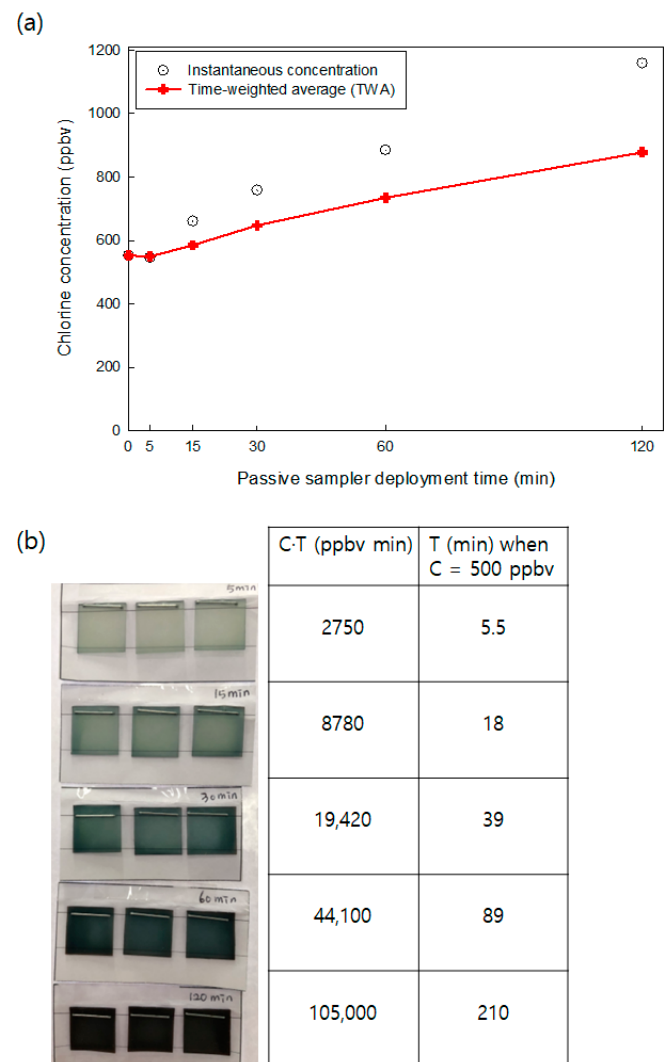
Figure 1. ( a ) Instantaneous chlorine concentration and time-weighted average (TWA) chlorine con- centration (ppbv) in the 125 L chamber after spreading 20 mL NaOCl (available chlorine, 4.00–4.99%) solution. The chlorine concentrations were measured by PTR-MS. ( b ) Color change of passive sam- plers after 5–120 min of passive sampler deployment in the 125 L chamber. The table shows CT (TWA chlorine concentration × time, unit: ppbv min) at each time and the exposure time when chlorine con- centration was assumed to be 500 ppbv, with permissible exposure limits of chlorine reported by the Occupational Safety and Health Administration (OSHA) and acute exposure guideline 1